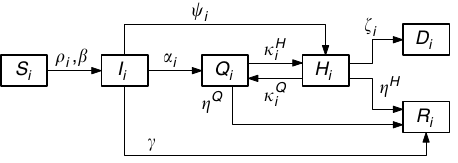
Fig. 5 Regional compartmental model structure adopted in our